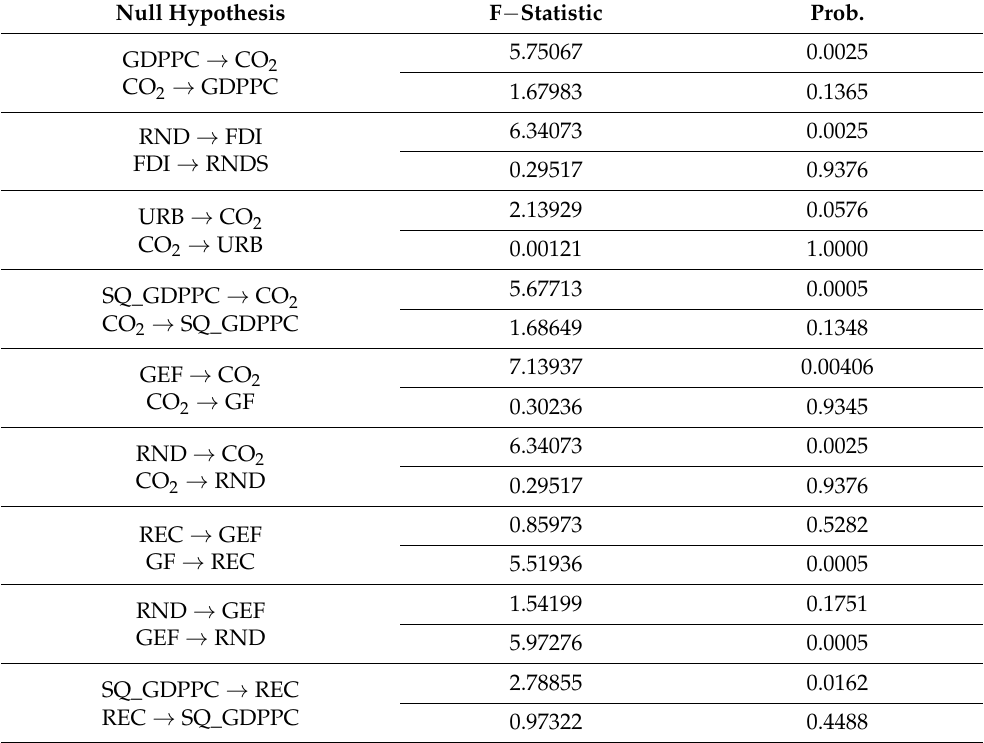
Table 9. Granger Causality Estimates.